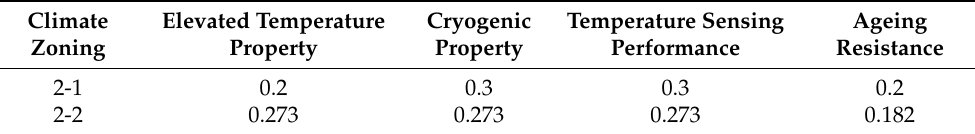
Ageing Resistance